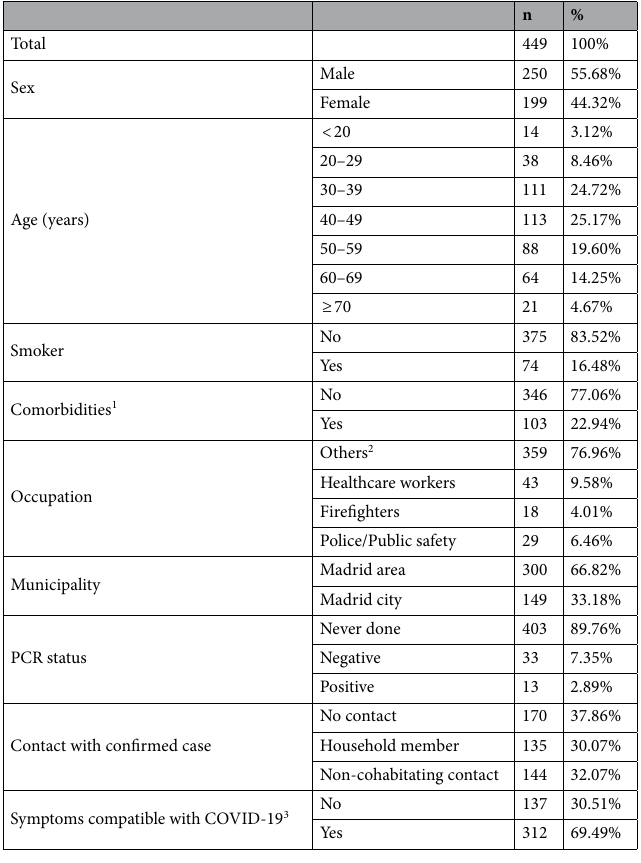
Table 1. Baseline characteristics of study participants. 1 Comorbidities include: vascular system and digestive tract diseases, hypothyroidism, epilepsy, diabetes, chronic respiratory disease (asthma, allergy, COPD), cancers and autoimmune disorders. 2 Those patients that are not among the other three specific professions. 3 Fever, headache, cough, odynophagia, asthenia, myalgia, ageusia, anosmia, dyspnea, gastrointestinal symptoms, cutaneous manifestations and/or pneumonia